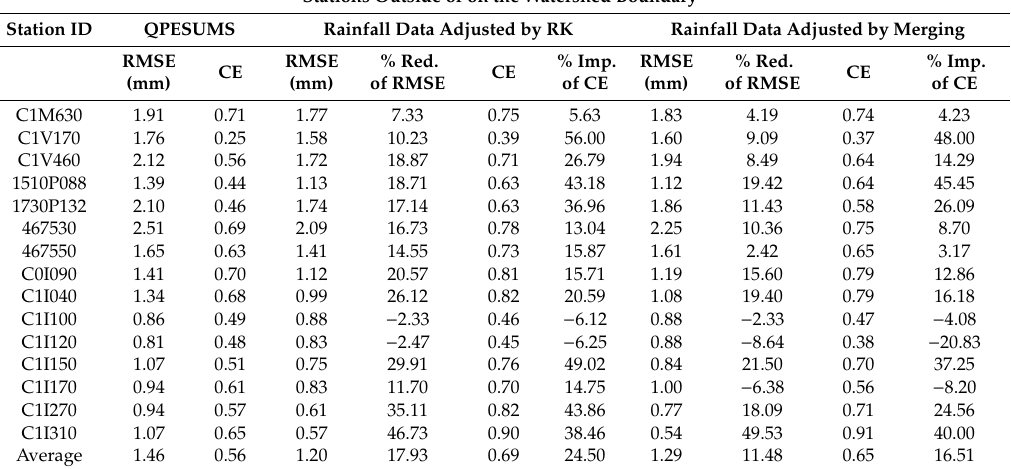
Table 6. RMSE and CE for the unadjusted QPESUMS data and adjusted radar rainfall values using RK and merging for stations outside or on the watershed boundary during the event of Typhoon Morakot. The values of the percentage reduction (% Red.) in the RMSE and percentage improvement (% Imp.) in CE are also